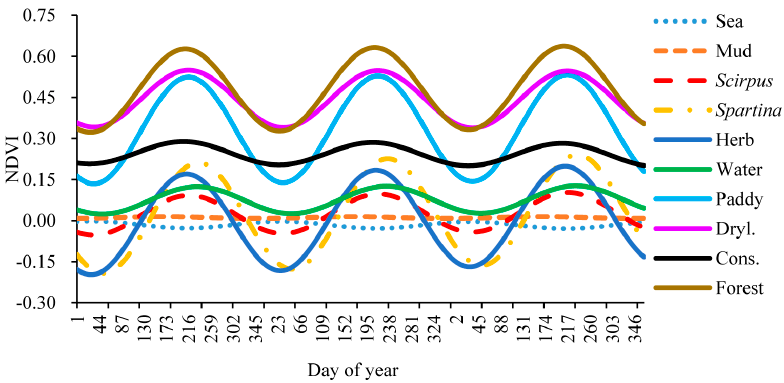
Figure 3. Fitted lines of each land cover type based on the parameters from time-series models (note: Dryl., dryland; Cons., construction land).